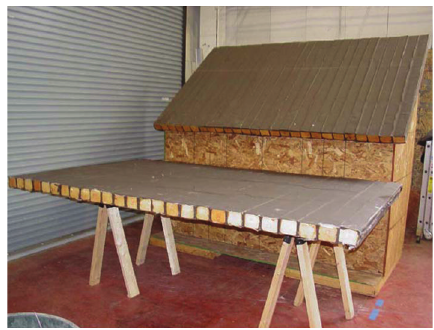
Figure 14: Biobased composite roof panels; one of them is mounted on a demonstration house made of timber [184].